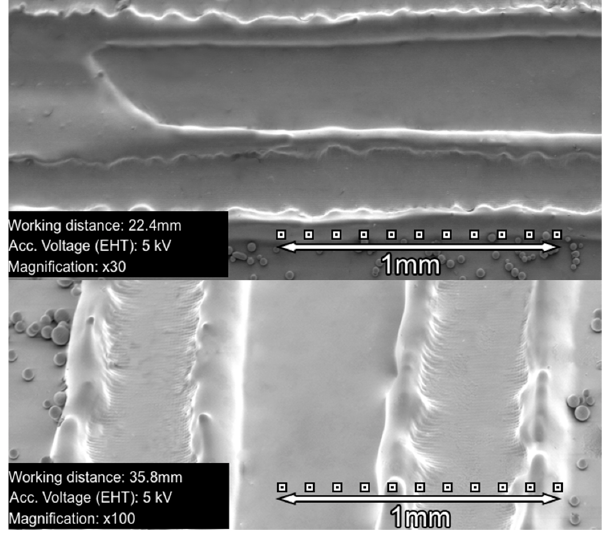
Figure 3. SEM images of a 672 µm blazed grating recorded in a 30-µm thickness NPC material.